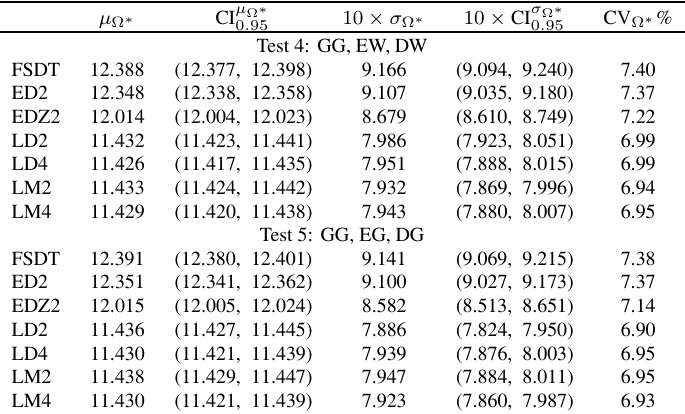
Ω ∗ statistic estimators in the case of the anti-symmetric laminate, fi rst material and